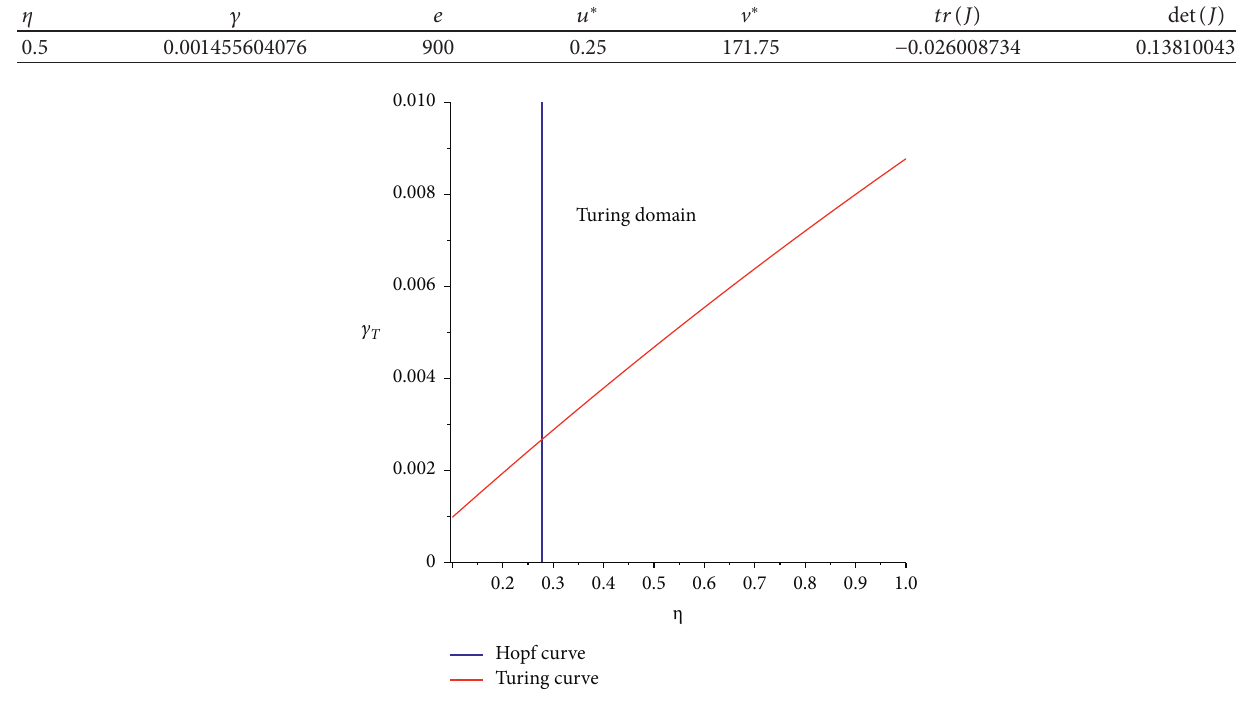
Figure 1: Turing domain of model